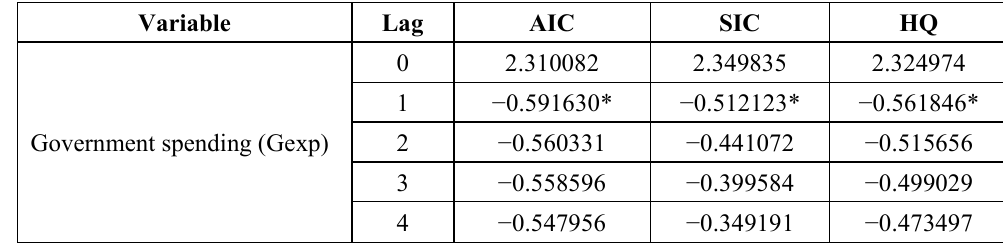
Table 6. Optimal Lag Selection Result for Government Spending